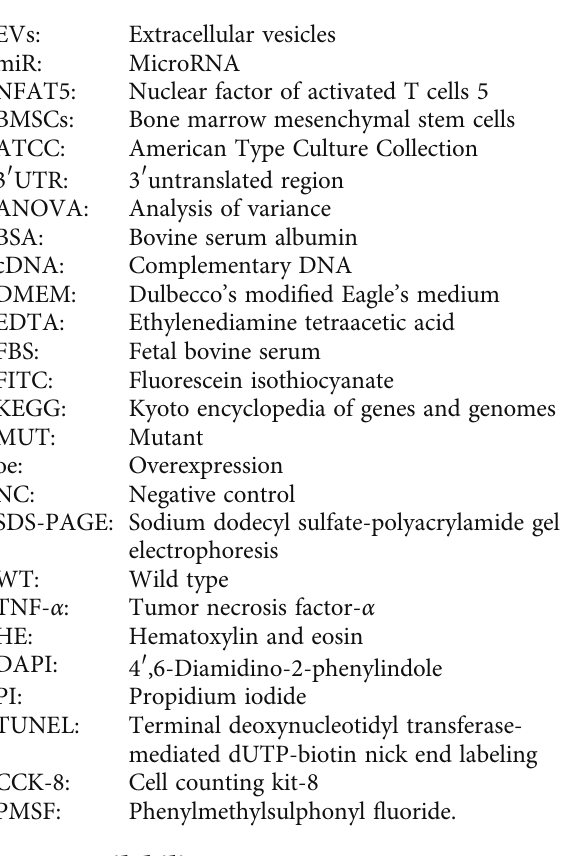
Supplementary 1 . Supplementary Figure 1: hBMSC identi fi